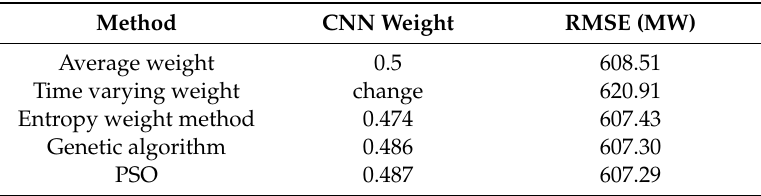
Table 4. Statistical effect of combination weighting.